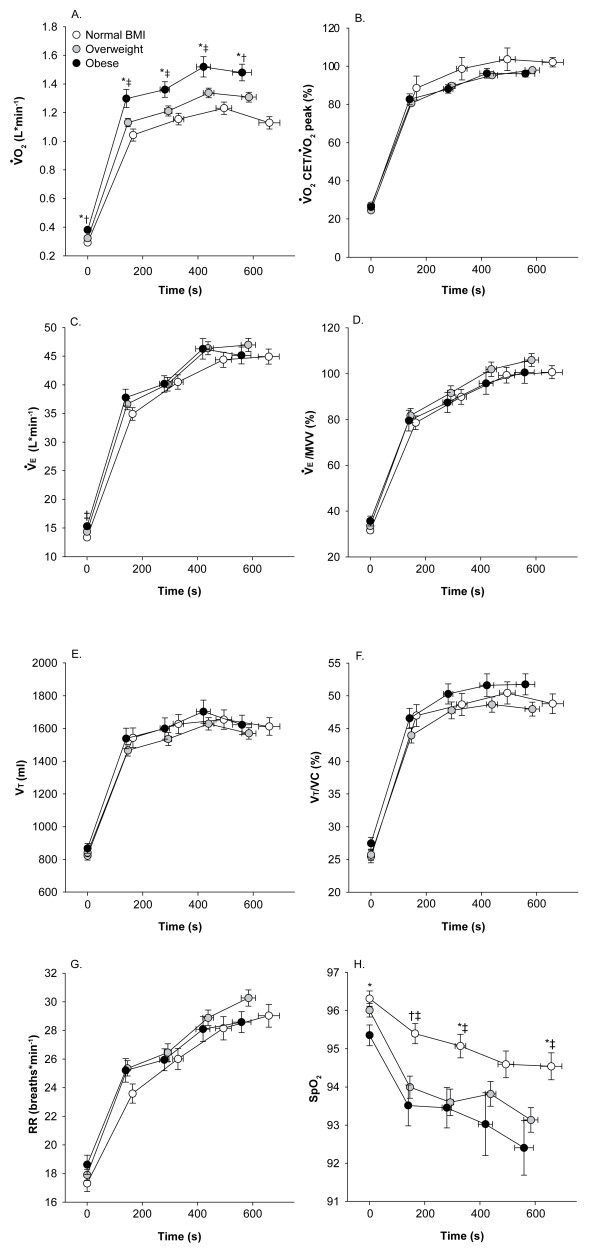
Oxygen consumption (VO2, L·min-1 [panel A] and as a % of peak incremental values [panel B]) during constant workrate exercise (CET), ventilation (VE, L·min-1 [panel C] and as a % of MVV [panel D]), tidal volume (VT, ml [panel E) and as a % of vital capacity [panel F]), respiratory rate (RR, breaths·min-1) and O2 pulse saturation (SpO2) in relation to constant workrate endurance time (s). Values are mean ± SE. White filled circles are normal BMI, grey are overweight and black, obese patients. * = p < 0.0001; † = p < 0.01; ‡ = p < 0.001.